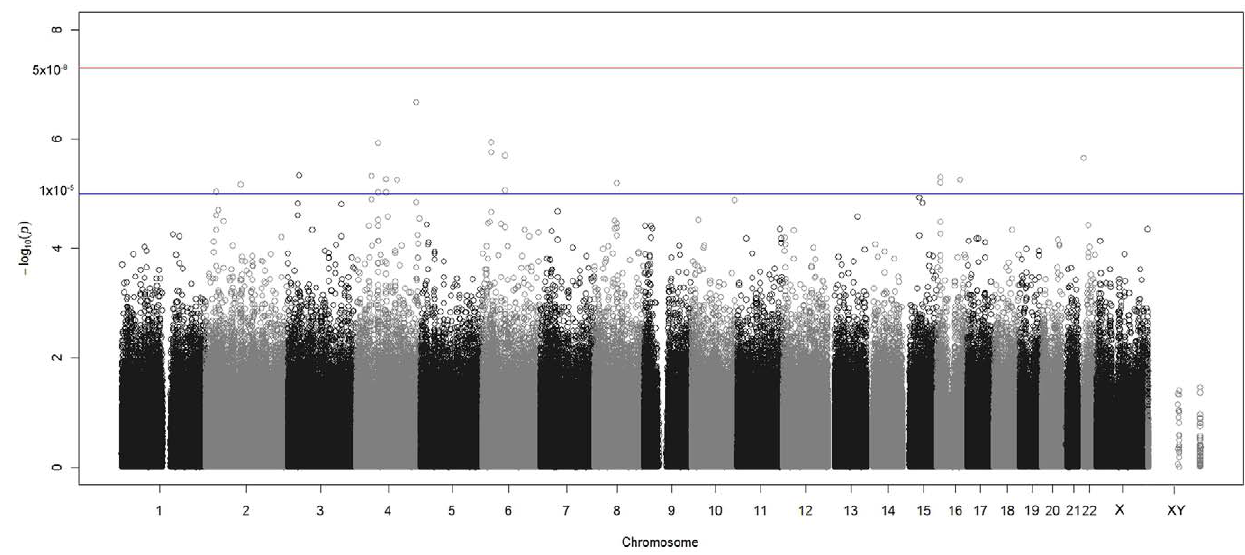
Figure 2. Manhattan plot for analysis of plasma HIV-1 set point. -log 10 (p) is plotted for all SNPs against physical location of each SNP in the genome (listed by chromosome number 1 through 22, and X and XY). The threshold for genome-wide significance is indicated.